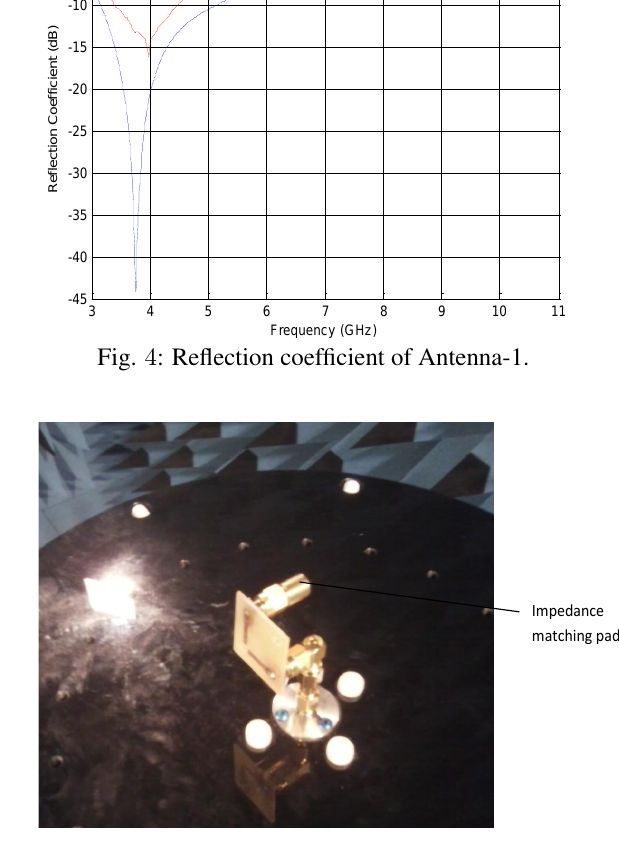
Fig. 5 : Measurement setup of radiation pattern.